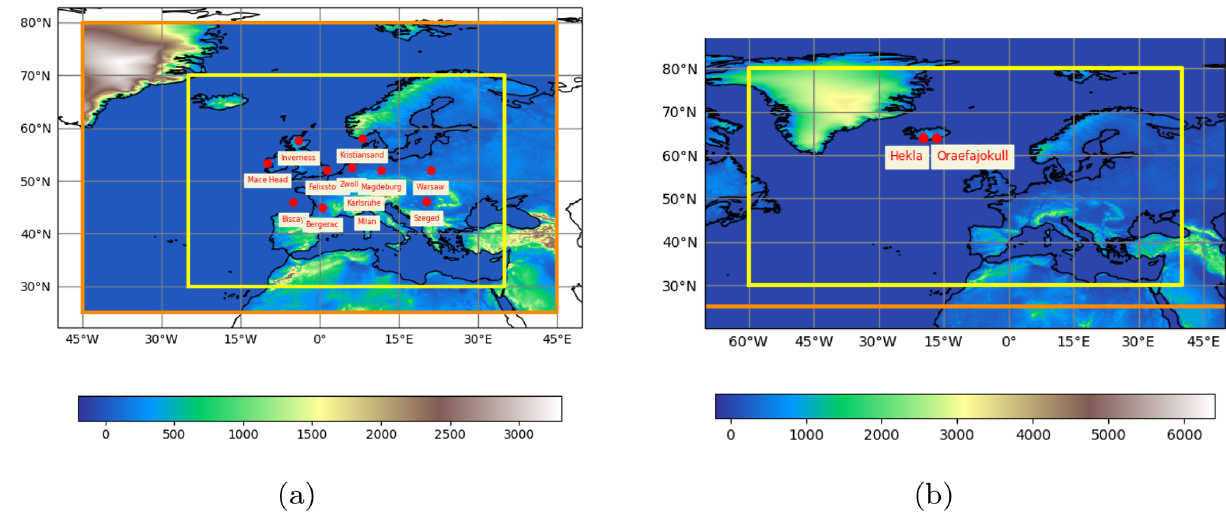
Figure 1. Release locations, modelling domain (orange box), and output domain (yellow box) for each scenario. (a) Radiological scenario and (b) volcanic eruption scenario. Note that the modelling domain for the volcanic ash scenario was the whole of the Northern Hemisphere north of 25 ◦